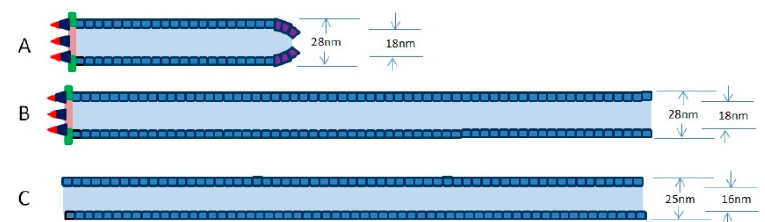
Figure 1. Simplified schemes of preformed capsid and tubular structure in cells infected with viable viruses ( A ) or inviable viruses ( B , C ). ( A ) A preformed capsid of nearly full length containing an apical cap, a cylindrical sheath, and a basal structure. ( B ) A preformed capsid grows longer and longer as a long tube when they are not packaged into viral genomes in time. ( C ) Excess VP39 proteins tend to self-assemble into the long tubular structure. In ( A , B ), the tubes are similar to W-tube (outer diameter of 28 nm and inner diameter of 18 nm), and the tube in ( C ) is similar to an N-tube (outer diameter of 25 nm and inner diameter of 16 nm).